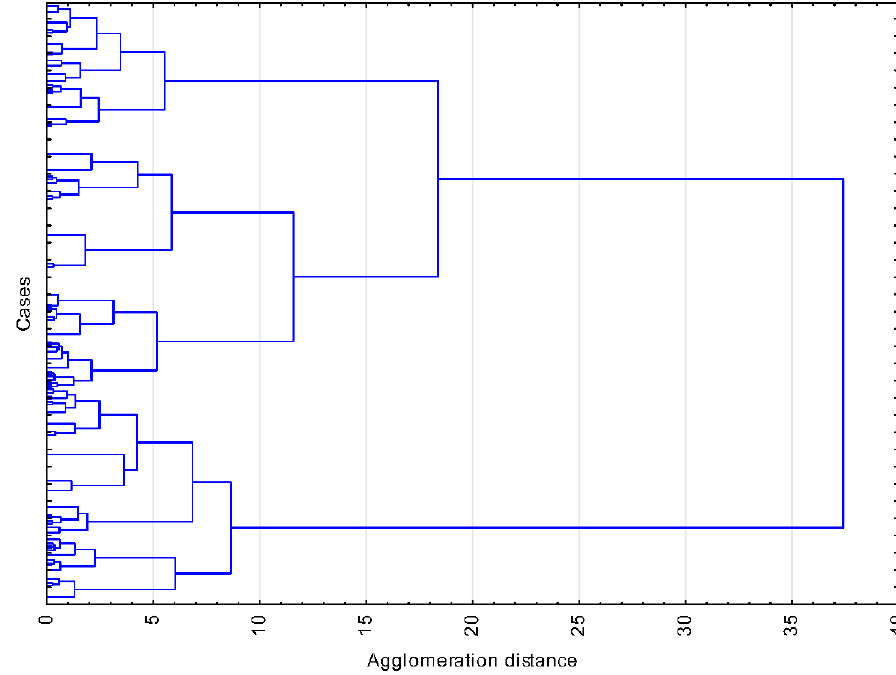
Figure 3. Agglomeration of Ward’s method.